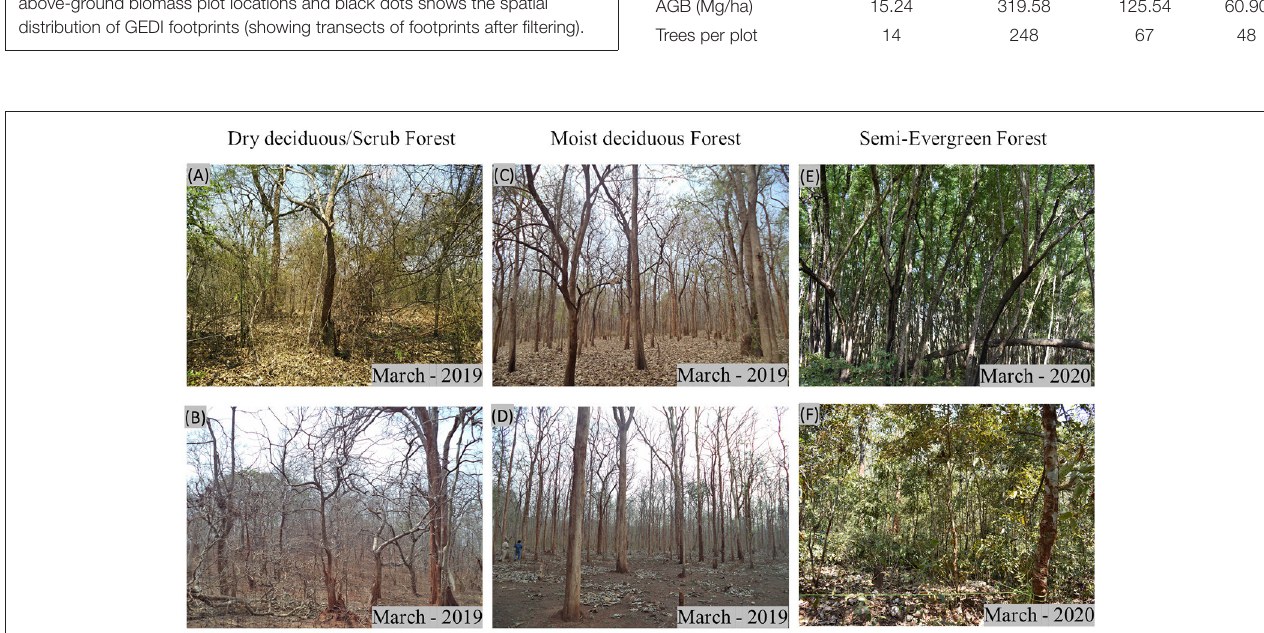
FIGURE 2 | Photographs showing different forest types- (A) and (B) Dry deciduous or scrub forest, (C) and (D) Moist deciduous forest, and (E) and (F) Semi-Evergreen forest. The date of acquisition of the photographs is provided at the bottom right of each photo.